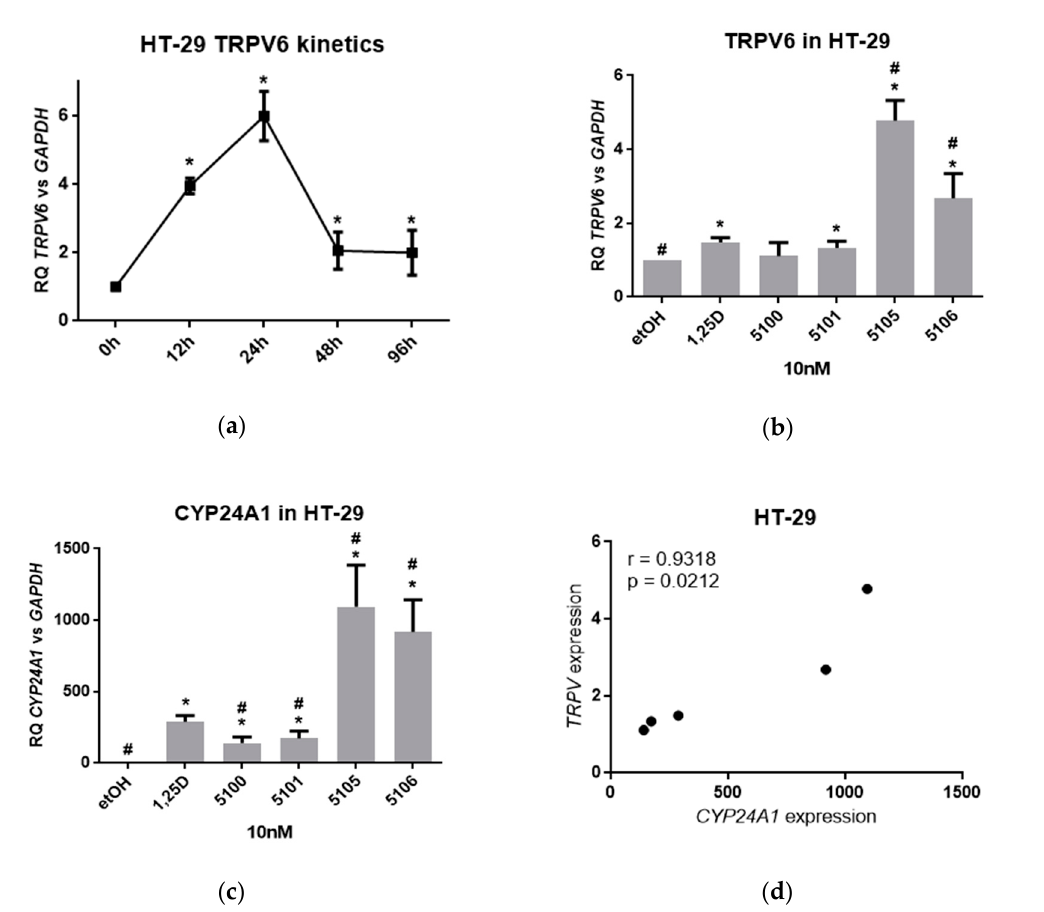
Figure 3. Activities of analogs towards HT-29 cells. ( a ) HT-29 cells were exposed to 10 nM 1,25D3 for a di ff erent time and then the expression of TRPV1 mRNA was measured by real-time PCR. The graph shows mean values ( ± SD) of the fold changes in mRNA levels relative to GAPDH mRNA levels. Values that di ff er significantly from those obtained for control cells are marked with *; ( b ) HT-29 cells were exposed to 10 nM 1,25D3, or 10 nM analogs and after 24 h the expression of TRPV1 mRNA was measured by real-time PCR. The bar charts show the mean values ( ± SD) of the fold changes in mRNA levels relative to GAPDH mRNA levels. Values that di ff er significantly from those obtained for control cells are marked with *, while the values that di ff er significantly from those obtained for 1,25D3-treated cells are marked by #; ( c ) HT-29 cells were exposed to 10 nM 1,25D3 or 10 nM analogs, and after 24 h the expression of CYP24A1 mRNA was measured by real-time PCR. The graph shows the mean values ( ± SD) of the fold changes in mRNA levels relative to GAPDH mRNA levels. Values that di ff er significantly from those obtained for control cells are marked with *; ( d ) Correlation between TRPV -inducing activities of analogs and their CYP24A1 -inducing